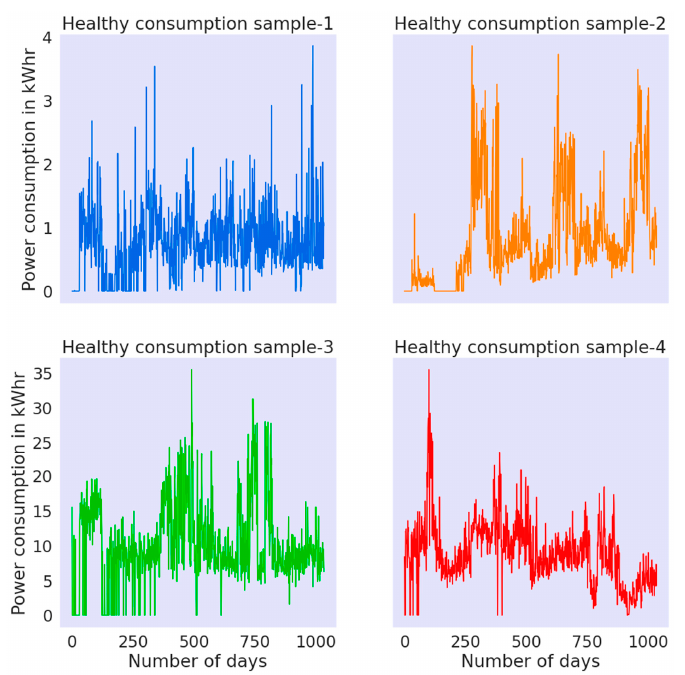
Figure 4. Healthy consumers: electric consumption pattern in the acquired dataset.